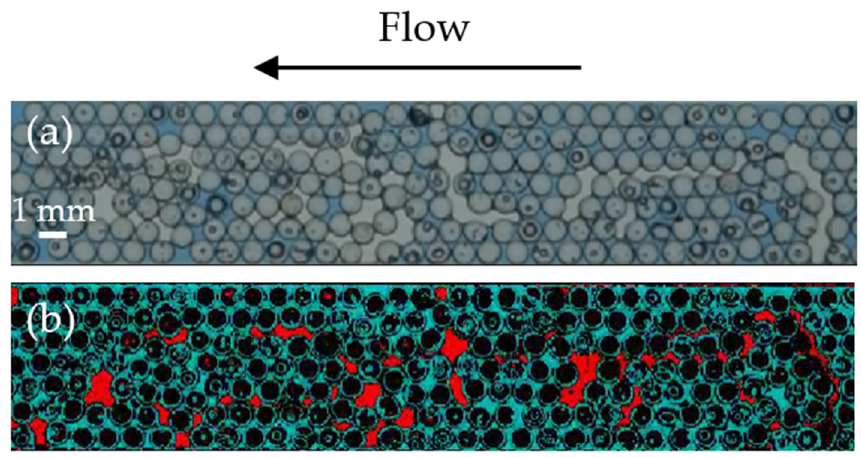
Figure 2. Visual data analysis. ( a ) An example frame from the 0.8 mm microchannel. ( b ) The corresponding visual data RGB analysis result. Blue represents water, red represents air, and black represents porous media.